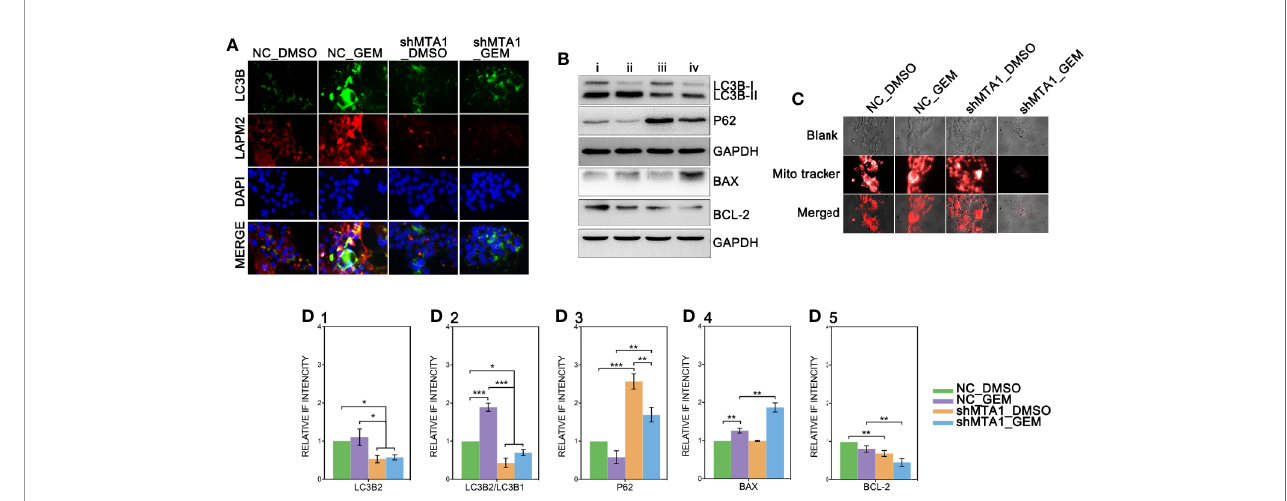
FIGURE 7 | MTA1-knockdown restricts the autophagy process in MCF-7 cells. (1) NC_MCF-7 and shMTA1_MCF-7 cells are planted in 24-cell plates for 24h, followed by 48h-treatment of 5 m M GEM or DMSO, then for IF assay for autophagy (A) . (2) NC_MCF-7 and shMTA1_MCF-7 cells are planted in 6-cell plates for 24h, followed by 48h-treatment of 5 m M_GEM or DMSO (4 groups: NC_DMSO, NC_GEM, shMTA1_DMSO and shMTA1_GEM), then for WB assay for autophagy and apoptosis associated protein (B, D 1-5 ) . (5) NC_MCF-7 and shMTA1_MCF-7 cells are planted in 24-cell plates for 24h, followed by 48h-treatment of 5 m M_GEM or DMSO (4 groups: NC_DMSO, NC_GEM, shMTA1_DMSO and shMTA1_GEM), then for mitochondrial viability assay (C)